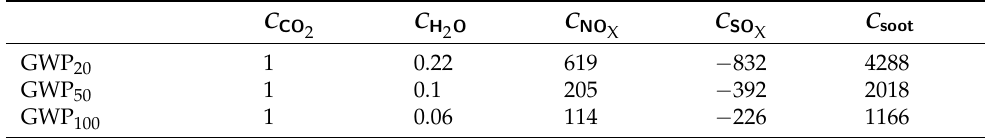
Table 1. GWP cost function coefficients.